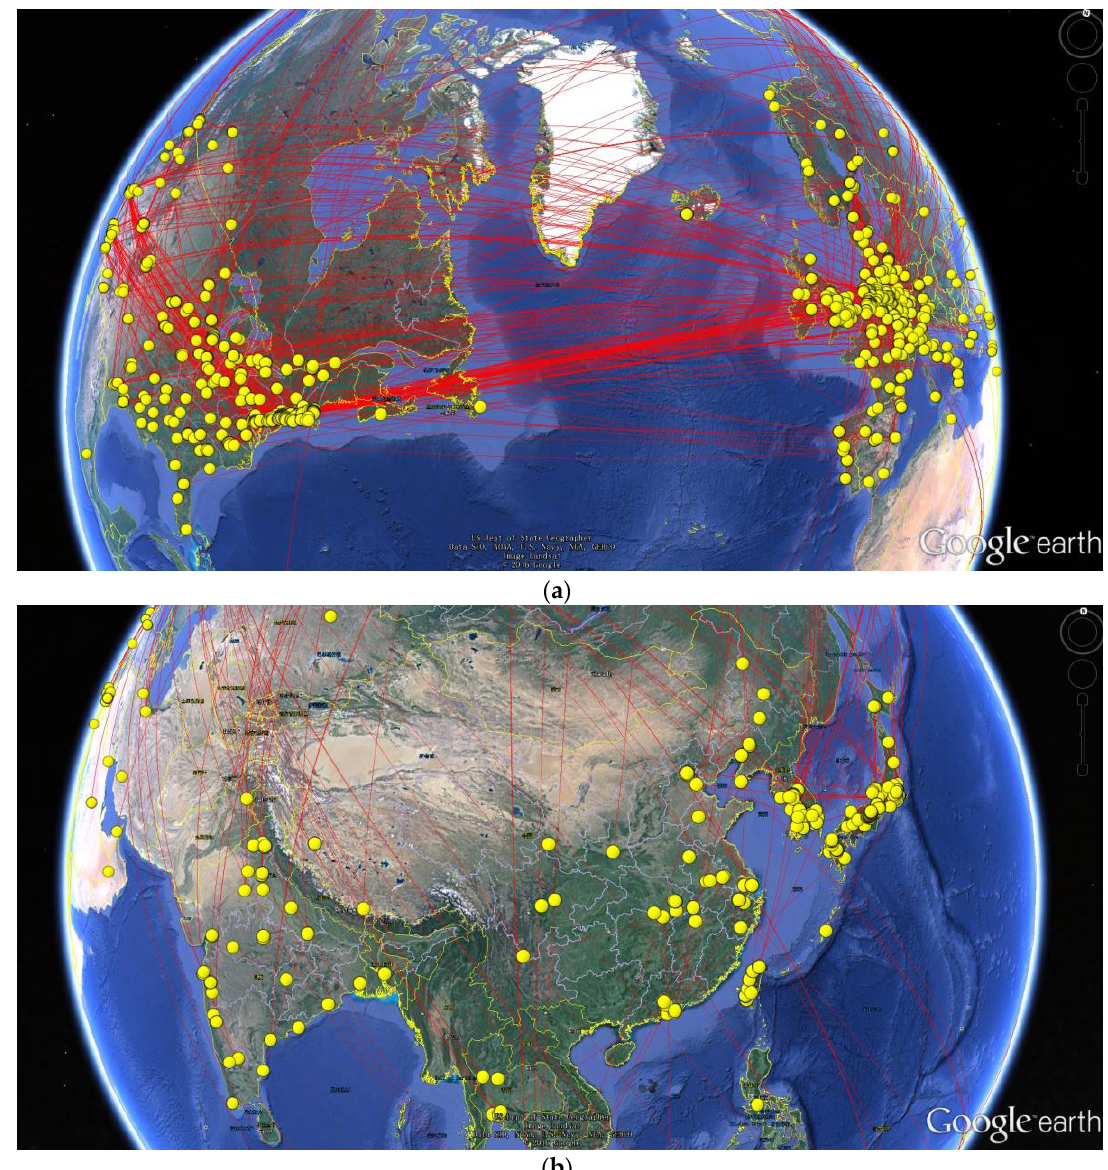
Figure 4. Global geographic distributions of authors according to the total number of publications by country: ( a ) North America and Europe; ( b ) Asia. Each yellow node showed individual researches and one red link between two nodes represented the collaboration at one publication.